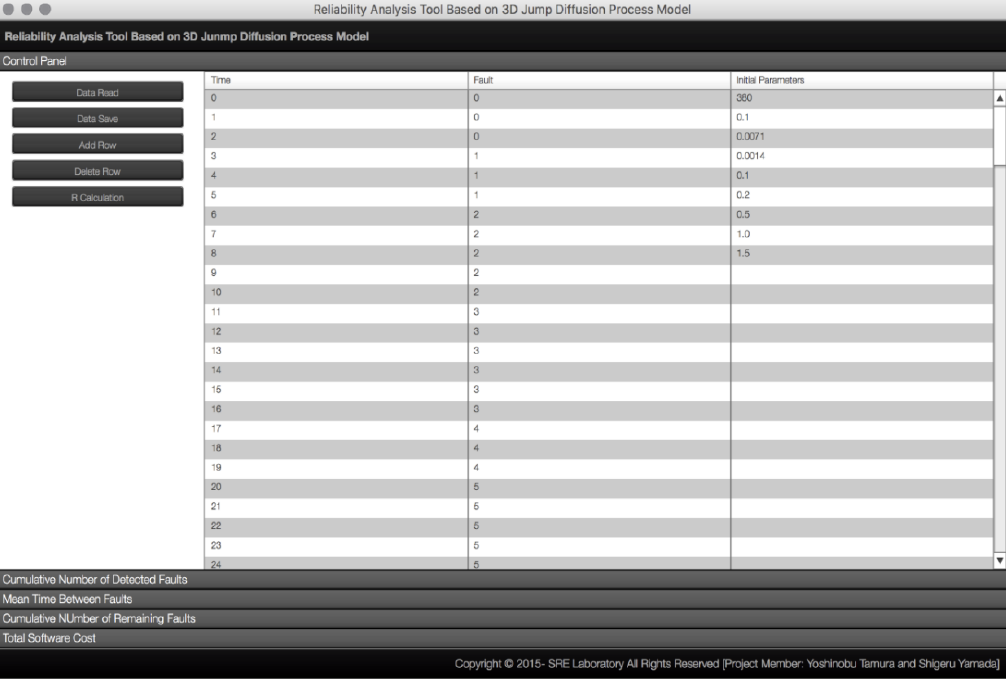
Fig. 1. The main screen of the developed AIR